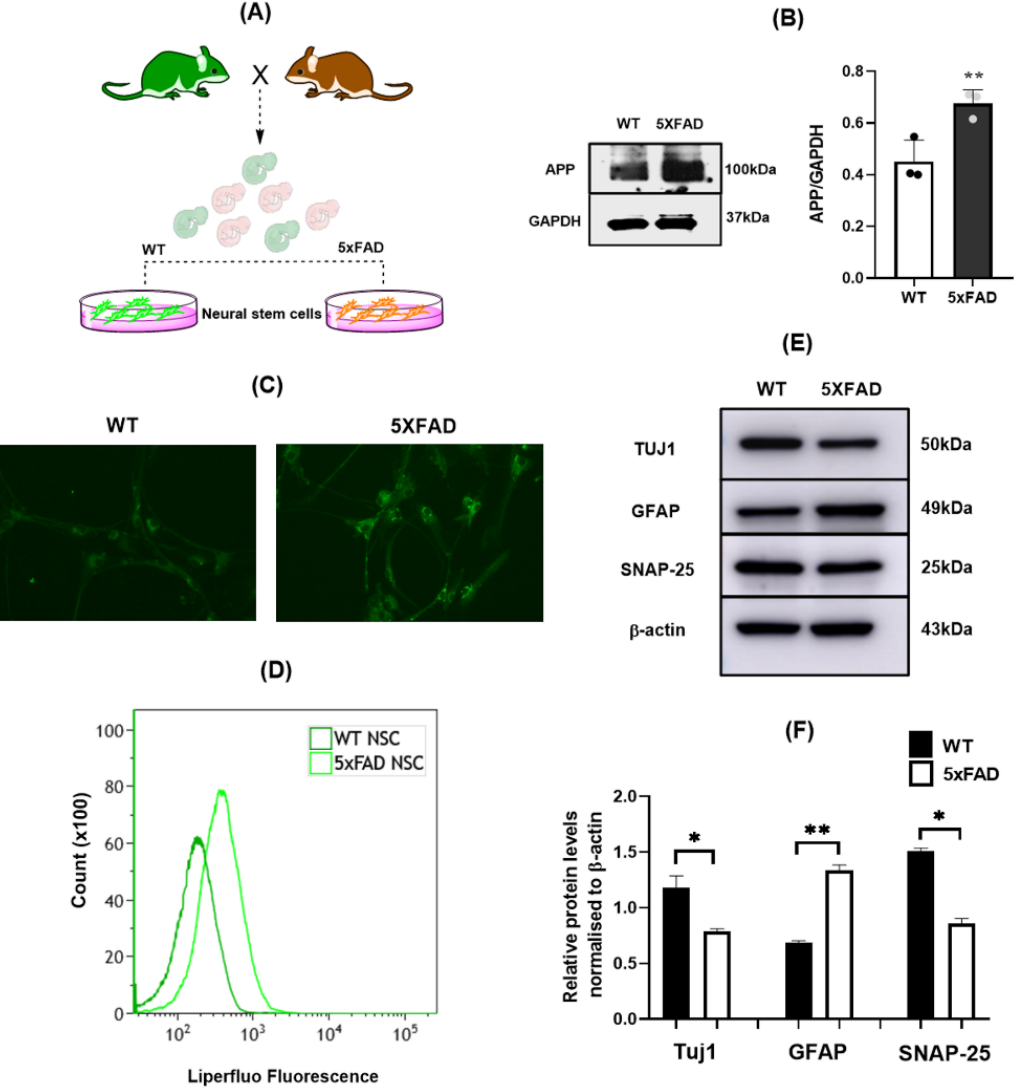
Figure 1. Increased lipid ROS and differentiation deficits in 5 × FAD NSC’s: ( A ). Graphical repre- sentation of culturing NSC’s from 5 × FAD and WT. ( B ). Western blots and densitometric analysis showing increased APP levels in 5 × FAD NSC’s. ( C ). Florescence microscopy images representing increased lipid ROS levels in 5 × FAD cells compared to WT via fluorescence intensity of Liperfluo dye. ( D ). Flow cytometry quantification of lipid ROS showing higher fluorescence of Liperfluo in 5 × FAD cells compared to WT cells. ( E ). Western blot representing expression of Tuj1, GFAP and SNAP-25 in 5 × FAD and WT NSC’s. ( F ). Densitometric analysis indicating levels of Tuj1, GFAP and SNAP in differentiated WT and 5 × FAD cultures. *: p < 0.05; **: p <